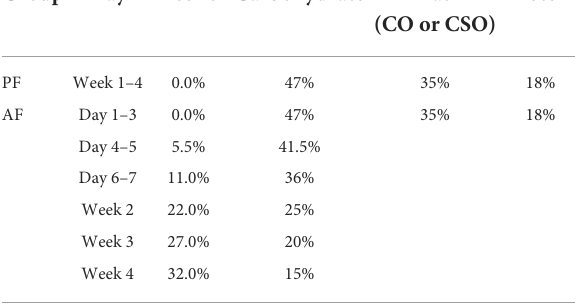
TABLE 1 The components of liquid diets.